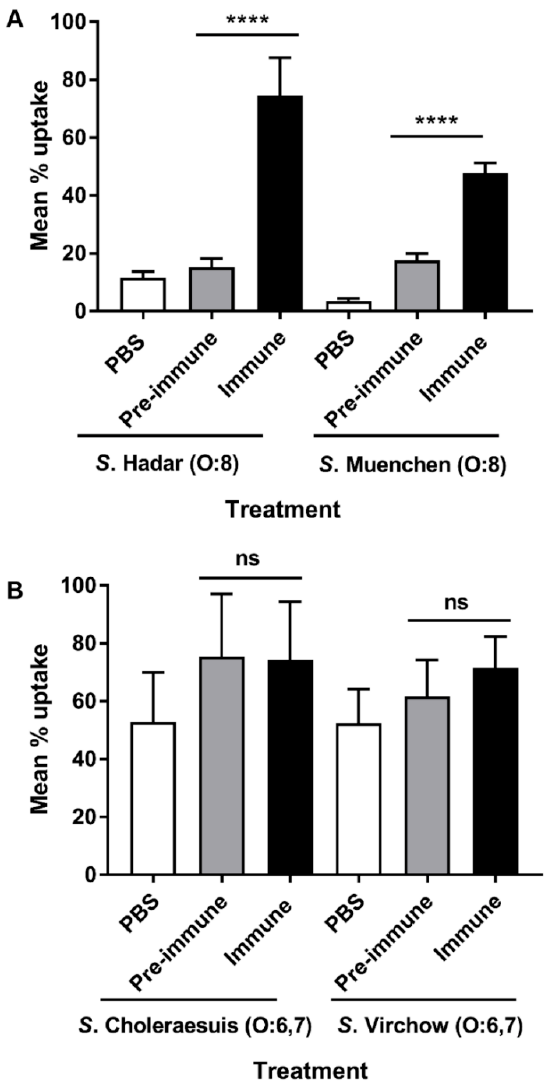
Figure 4. Opsonophagocytic uptake of Salmonella group O:6,7 (C 1 ) and O:8 (C 2 -C 3 ) serovars by J774 macrophages. ( A ) Serogroup O:8 (C 2 -C 3 ) strains ( S . Hadar and S . Muenchen) were opsonized with PBS, pre-immune or CVD 1979-immune sera prior to testing for uptake by J774 cells. ( B ) Serogroup O:6,7 (C 1 ) strains ( S . Choleraesuis and S . Virchow) were opsonized with PBS, pre-immune or CVD 1979-immune sera prior to testing for uptake by J774 cells. Data shown is the mean of three inde- pendent experiments and is presented as mean ± SEM. **** p < 0.0001; ns, not significant (unpaired two-tailed Student’s t -test).